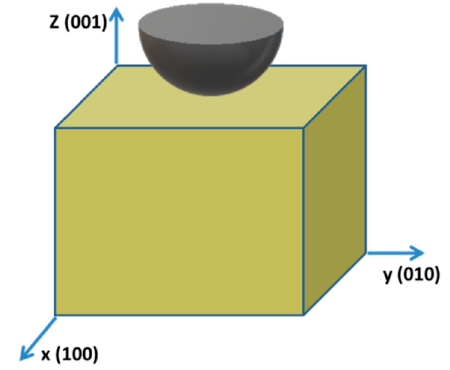
Figure 1. Schematic representation of nanoindentation simulations. Indentations performed in (001) direction. Virtual indenter is represented by a nonatomistic rigid sphere. Nanoindentation spot is at (x = 10 nm, y = 10 nm).